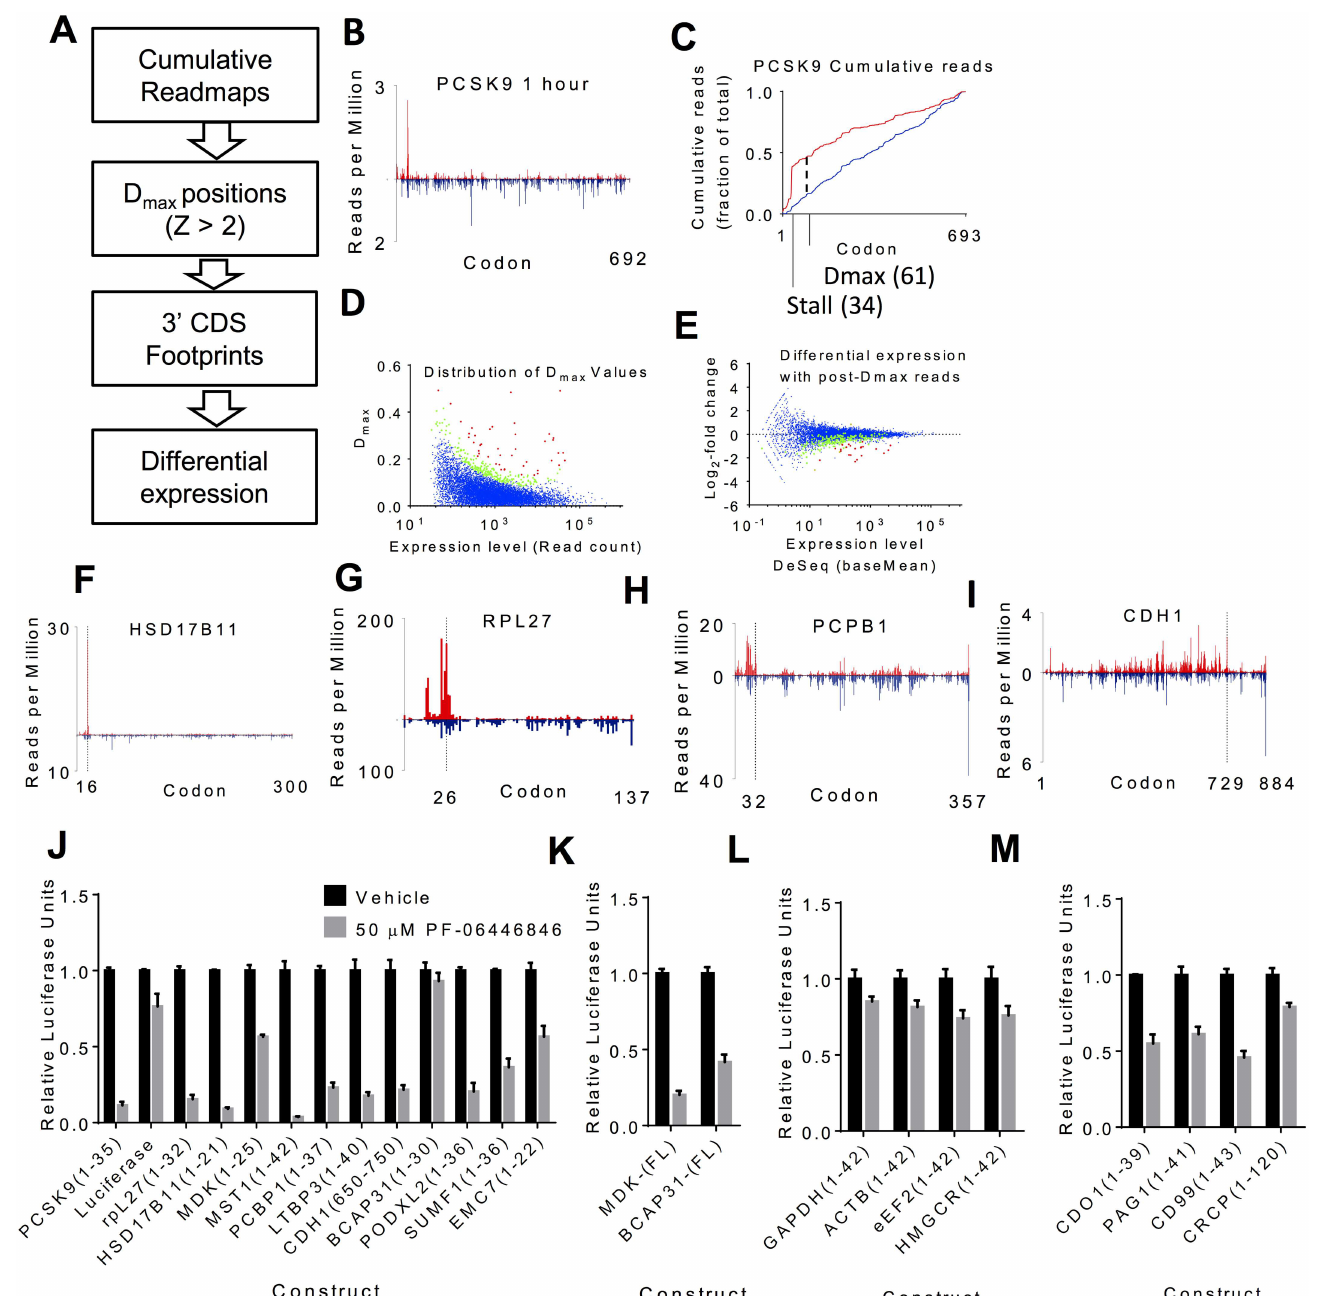
Fig 5. Identification and validation of PF-06446846–sensitive nascent chains. (A) Outline of the approachto identify PF-06446846–targeted mRNAs. (B) Example readplotand (C) examplecumulativefractional read (CFR) plot for proproteinconvertasesubtilisin/kexintype 9 (PCSK9). A CFR plot depicts at each codon the percentage of reads aligningat or 5´ to that codon. In all plots, data from 1.5 μ M PF-06446846 treatments are shown in red and vehicletreatments are shown in blue. The major stall and the positionof D max is marked. (D) Scatterplot showingthe distribution of D max values as a function of read counts; red indicatesD max Z-score > 3 (see Materialsand methods for Z-score calculations) and green indicates2 < Z-score < 3. (E) Scatterplot of fold changeversus expressionlevel when reads mapping3´ to D max position(for Z-score > 2) or codon50 (for Z-score < 2) are used. Genes for which D max Z-score > 2 and DeSeq fasle discovery rate (FDR) < 10% are highlightedin red, in green for Dmax Z-score > 2 but FDR > 10%, and in purplefor D max Z-score < 2 with FDR < 10%. (F–I) Example readplotsfor PF-06446846–sensitiveproteins(F) HSD17B11,(G) RPL27, (H) PCBP1, and (I) cadherin-1 (CDH1). Bars representing the treatment dataset are red and go upwardsand bars representingthe vehicledatasets are blue and go downwards. All graphs are derived from the 1-h treatment time in the first study. (J) Cell-free translationassays showinginhibitionof translationby 50 μ M PF-06446846when the stall sites identifiedby ribosome profilingare fused to the N-terminus of luciferase. (K) Inhibitionof in vitro